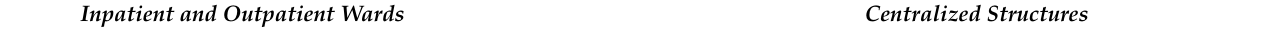
Category 2. Supporting